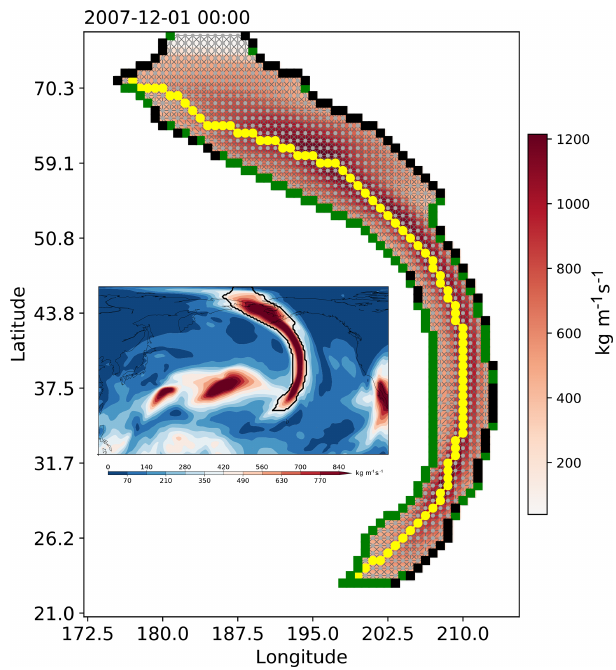
Figure 2. Application of the axis-finding algorithm on the AR in the North Pacific on 1 December 2007 at 00:00UTC. IVT within the AR is shown as colors, in kgm − 1 s − 1 . The region of the AR ( I k ) is shown as a collection of grey dots, which constitute nodes of the di- rected graph. Edges among neighboring nodes are created. A square marker is drawn at each boundary node and is filled with green if the boundary node has net input moisture fluxes ( n i ∈ L k, in ) and with black if it has net output moisture fluxes ( n i ∈ L k, out ). The found axis is highlighted in yellow. The inset image shows the IVT dis- tribution over the North Pacific with the selected AR highlighted in black